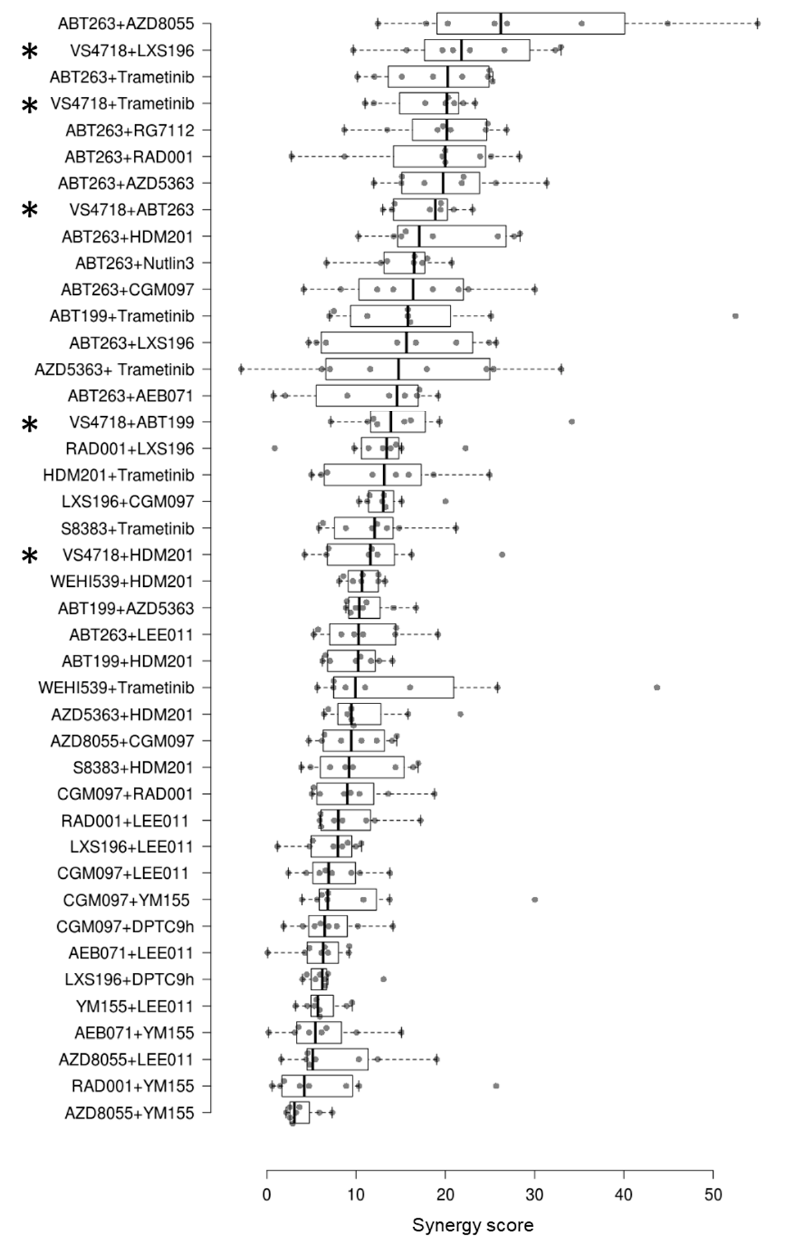
Figure 1. New ranking of drug combinations tested in uveal melanoma cell lines according to synergy scores. The screening of drug combinations was done in eight uveal melanoma cell lines. The FAK inhibitor (VS4718)-based combinations are indicated by asterisks. Each circle represents the synergy score for one cell line. The synergy scores of combinations not including the FAK inhibitor were previously reported in [27].